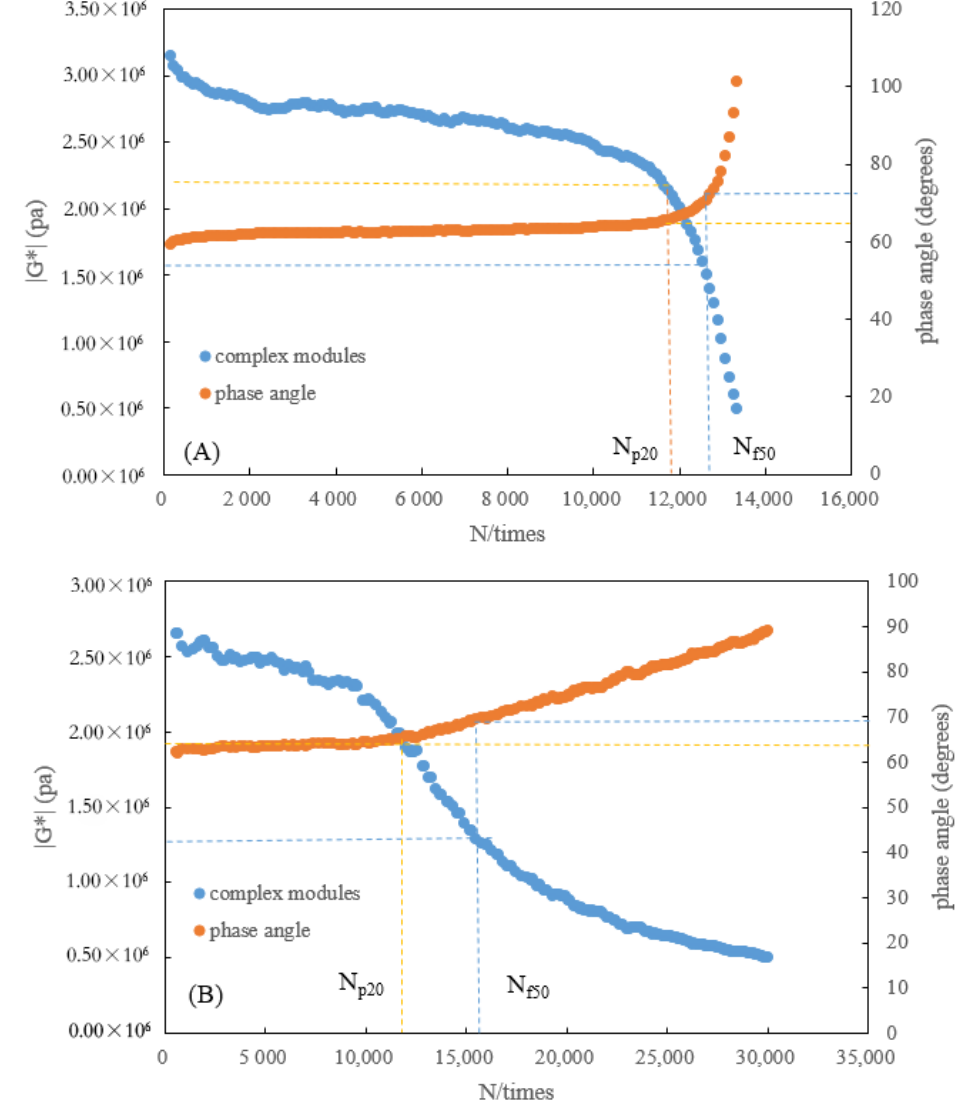
Figure 8. ( A ) Phase angle and complex modulus corresponding to N p20 and N f50 under stress-control. ( B ) Phase angle and complex modulus corresponding to N p20 and N f50 under strain-control.